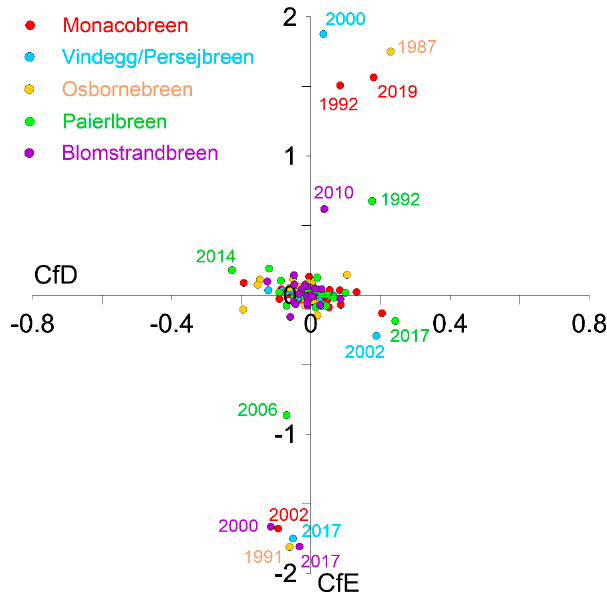
Figure 7. Interannual changes in the values of CfD and CfE indicators for five selected tidewaters glaciers surging between 1985 and 2017.